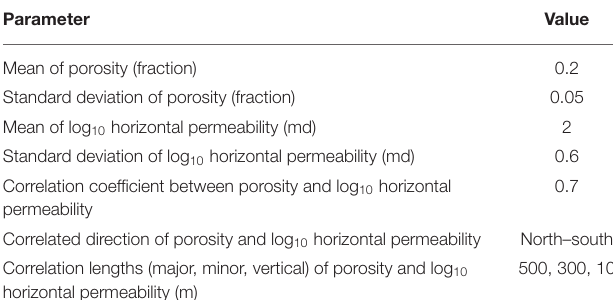
TABLE 5 | Statistical parameters used to generate the geological model.